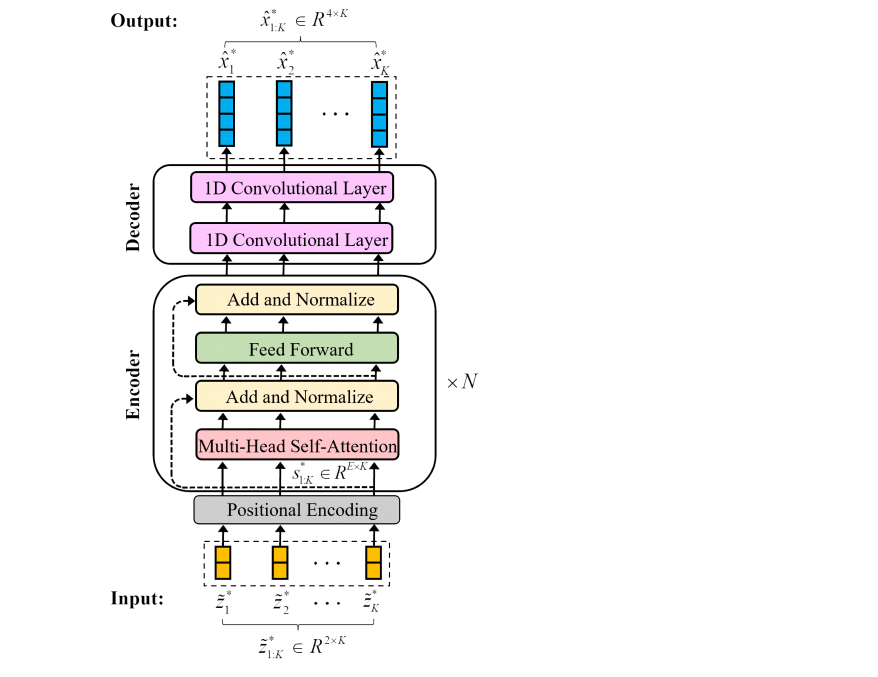
. ˜ z ∗ is first 1: K 1: K by 1: K